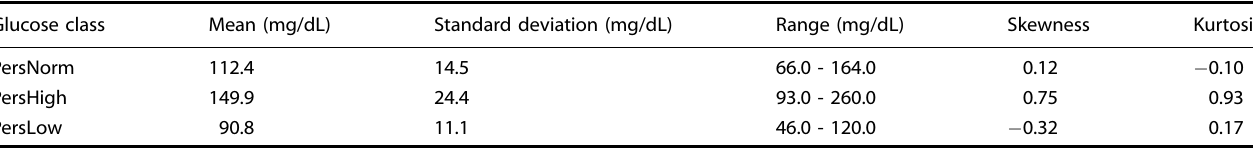
Table 1. Summary metrics of distributions of each personalized glucose de fi nition.